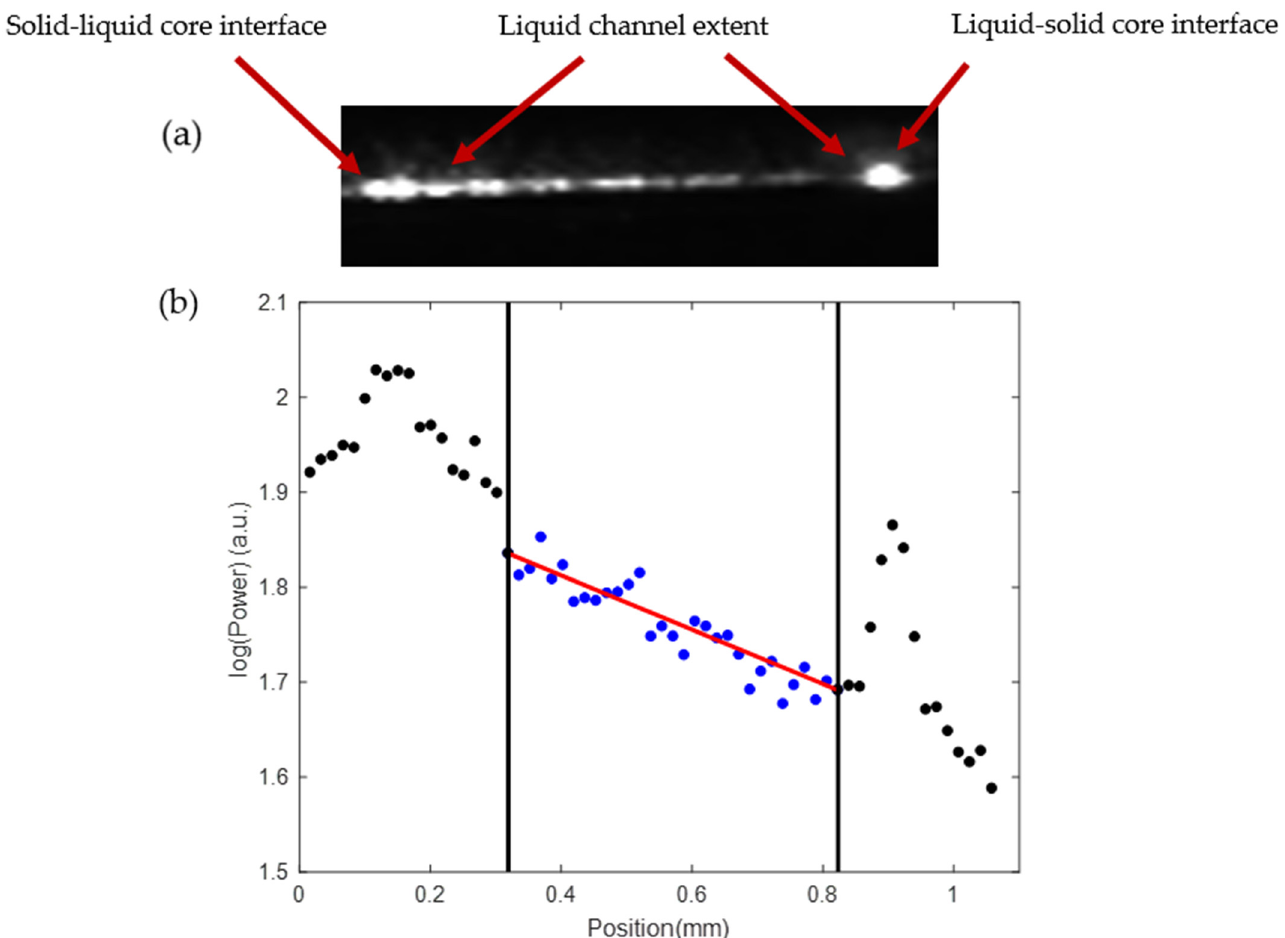
Figure 7. ( a ) Greyscale image of light propagating in the liquid channel. This image was used to determine the optical loss of the channel using top view scattering. ( b ) Intensity versus position plot using the top view scattering technique for a hollow core channel. The black points are solid to hollow waveguide interfaces. The interfaces cause scattering which results in significant loss. The blue points correspond to intensity values inside the LC region.